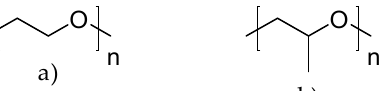
Figure 13. ( a ) Poly(ethylene glycol) (PEG) and ( b ) poly(propylene glycol) (PPG).